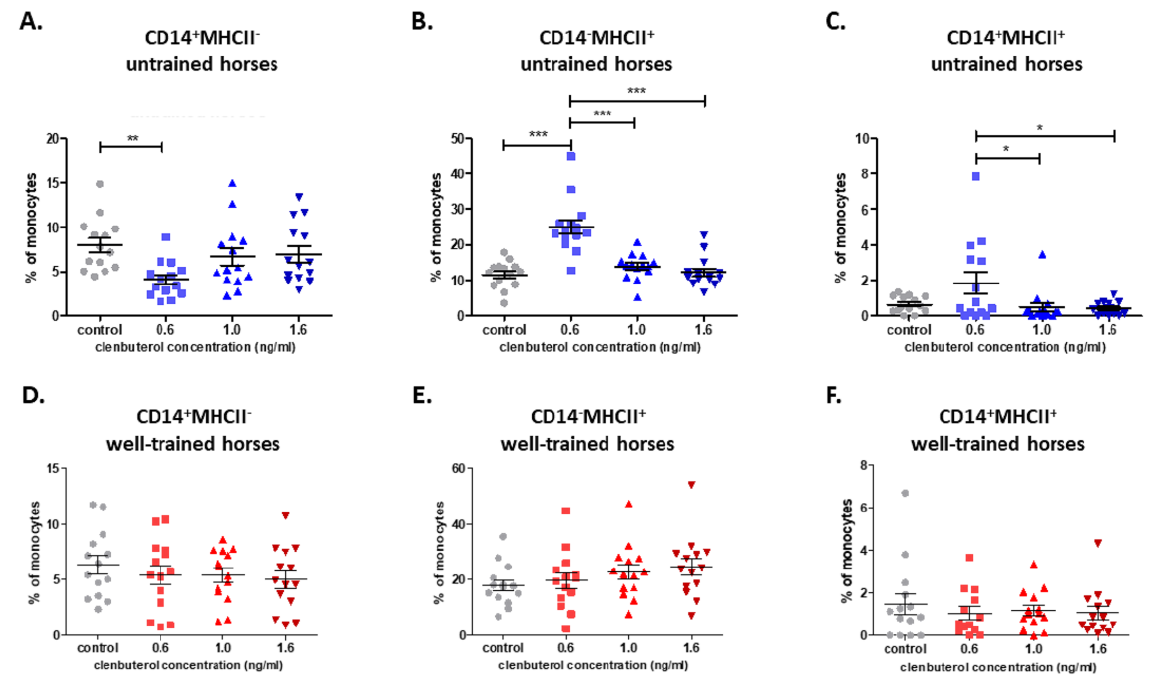
Figure 3. Graphic representation showing percentages of positive cells: CD14+MHCII− ( A , D ), CD14-MHCII+ ( B , E ), and CD14+MHCII+ ( C , F ) gated from total monocytes. Each dot represents one individual horse ( n = 28) and means ± SEM are presented. The significance levels are: * p < 0.05; ** p < 0.01, and *** p < 0.001.